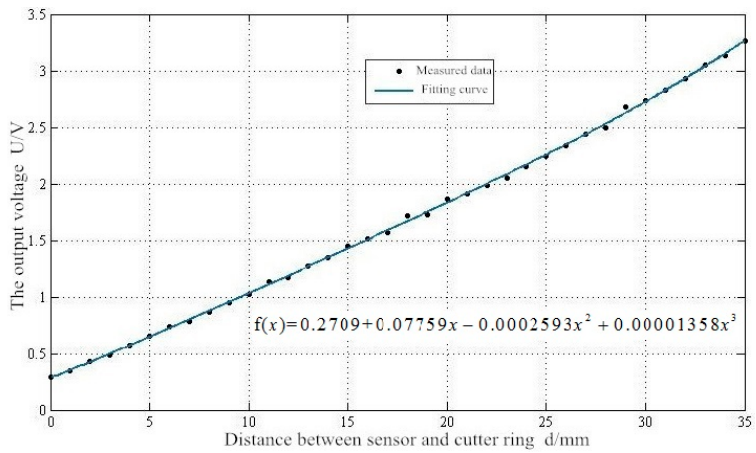
Figure 13. n = 3 Fitting curve.